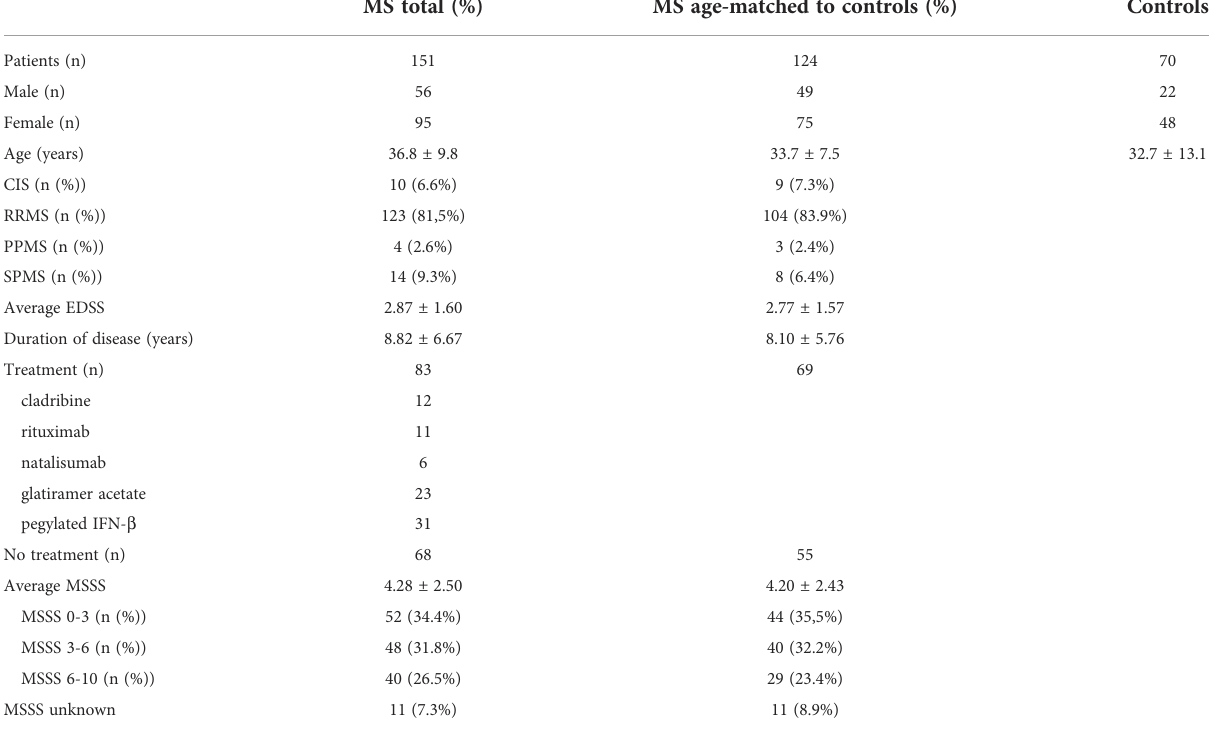
TABLE 1 Clinical characteristics of patients and controls included in the